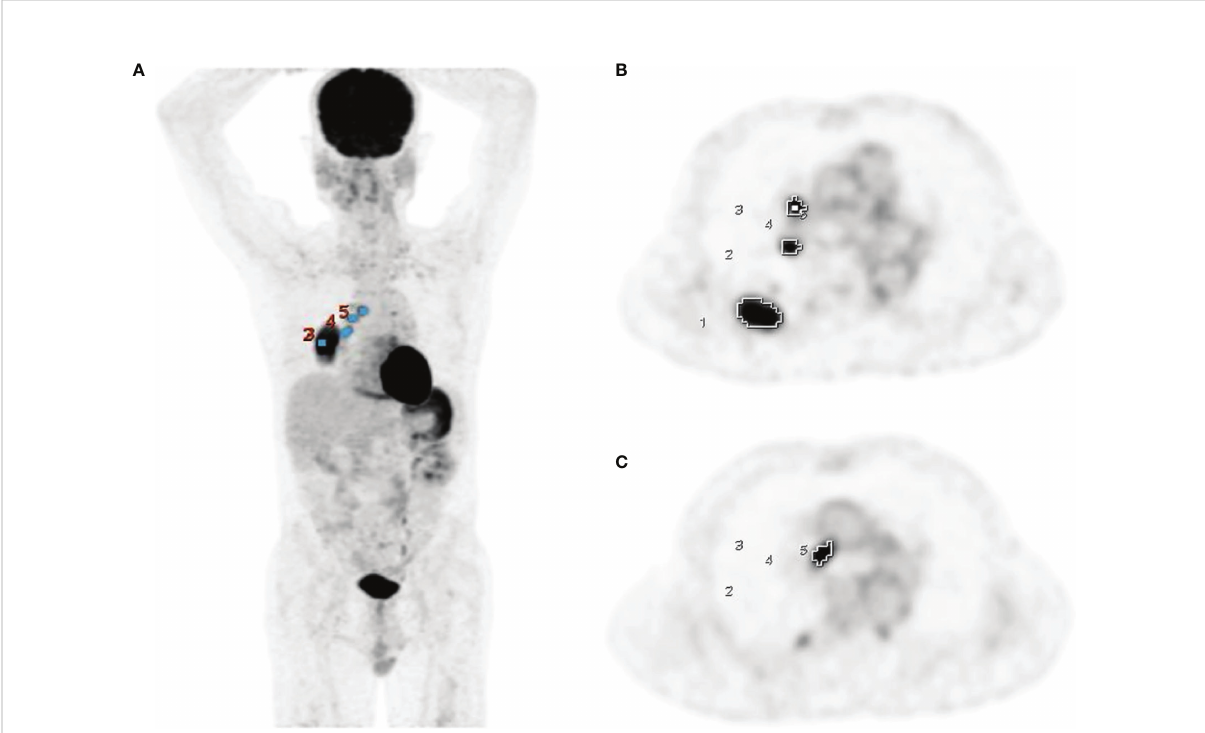
FIGURE 1 Measurement of PET parameters using PET VCAR on PET coronal (A) and axial images (B, C) in a 69-year-old man with